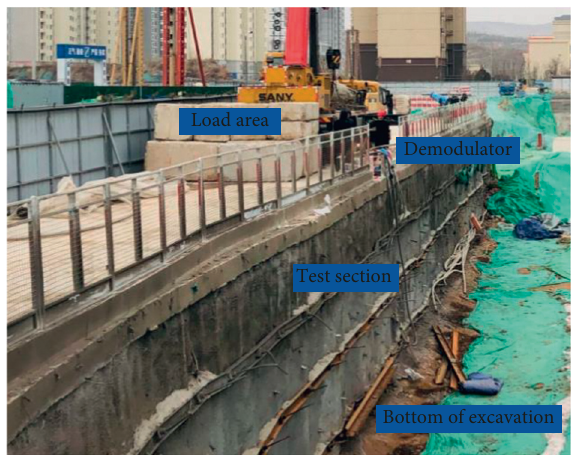
Figure 10: Arrangement of loading and unloading test.